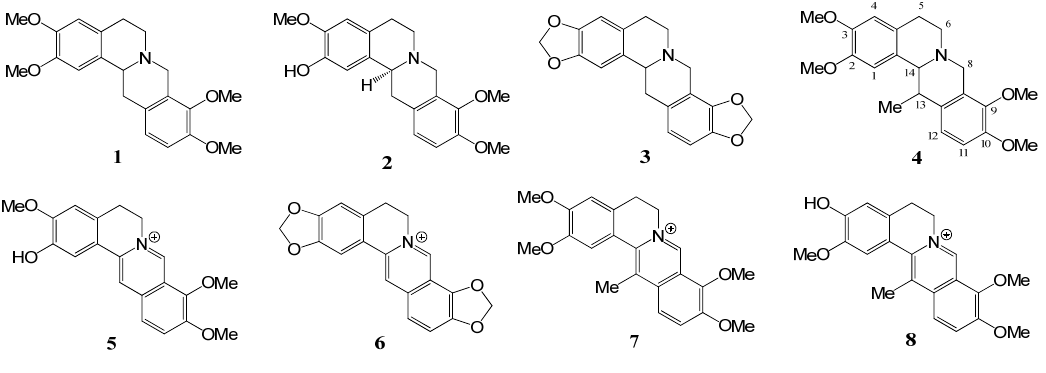
Figure 2. Chromatograms obtained from chiral separation of 2 (A), synthetic l - 2 (B) and dl - 2